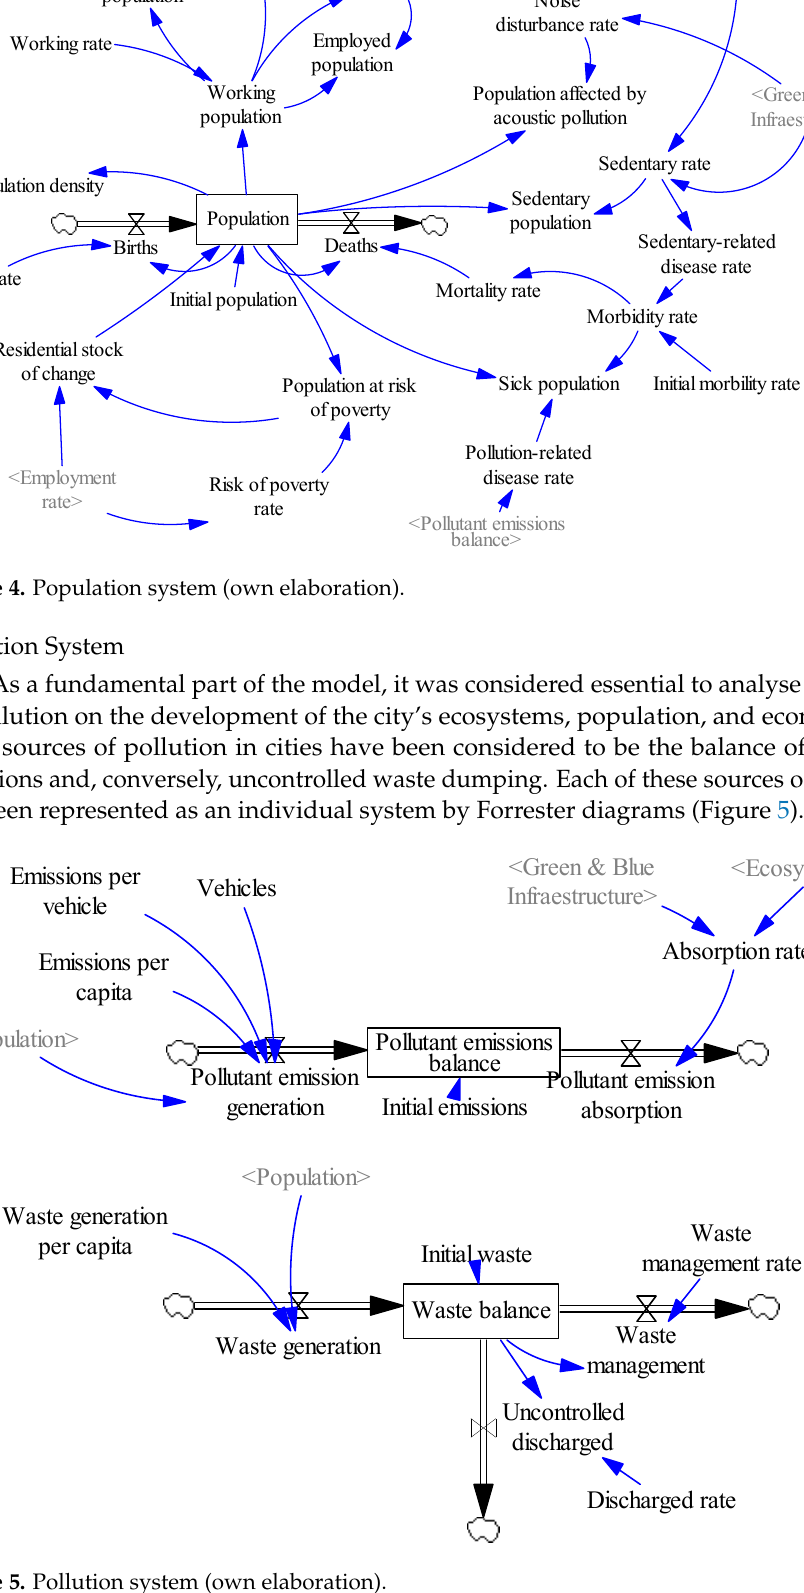
Figure 5. Pollution system (own elaboration).